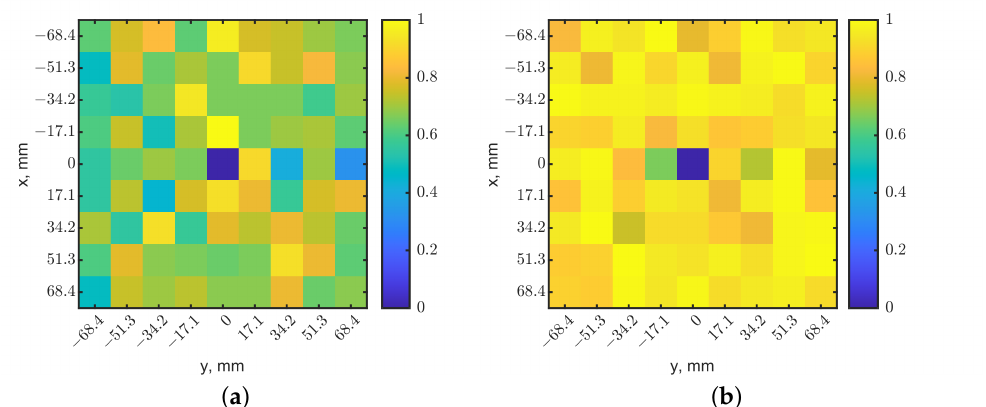
Figure 8. Normalized localization maps from ( a ) resonant frequencies and ( b ) magnitudes of reflection coefficients. The tumor is located in (x = 0, y = 0) at a depth of 10 mm. The dark-blue pixel indicates the tumor’s